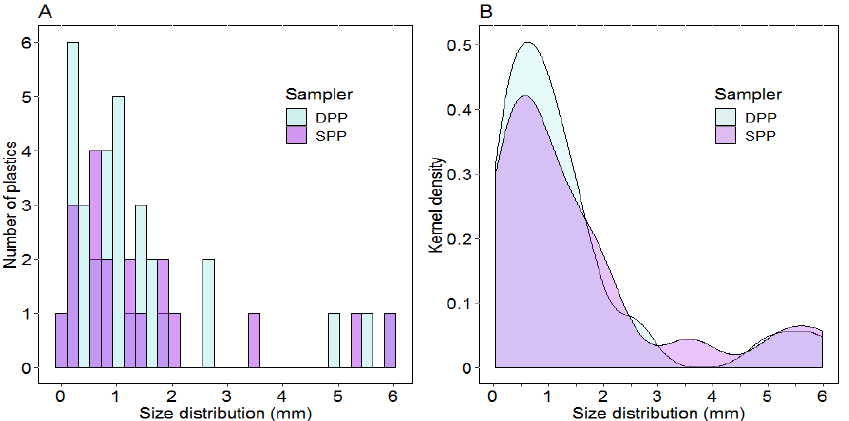
Figure 4. Size distribution ( A ) and kernel density ( B ) for plastic samples collected by deep-water and shallow-water plankton pumps. SPP represented shallow-water plankton pump; DPP represented deep-water plankton pump (DPP).